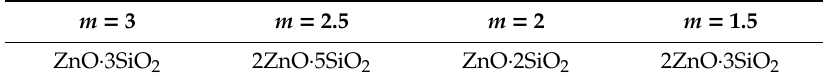
Table 1. Dependence of the silicate composition on the chosen modulus “ m ”. With lower modulus, the zinc content was increasing. The modulus used in the experiment is in bold. m = 3 m = 2.5